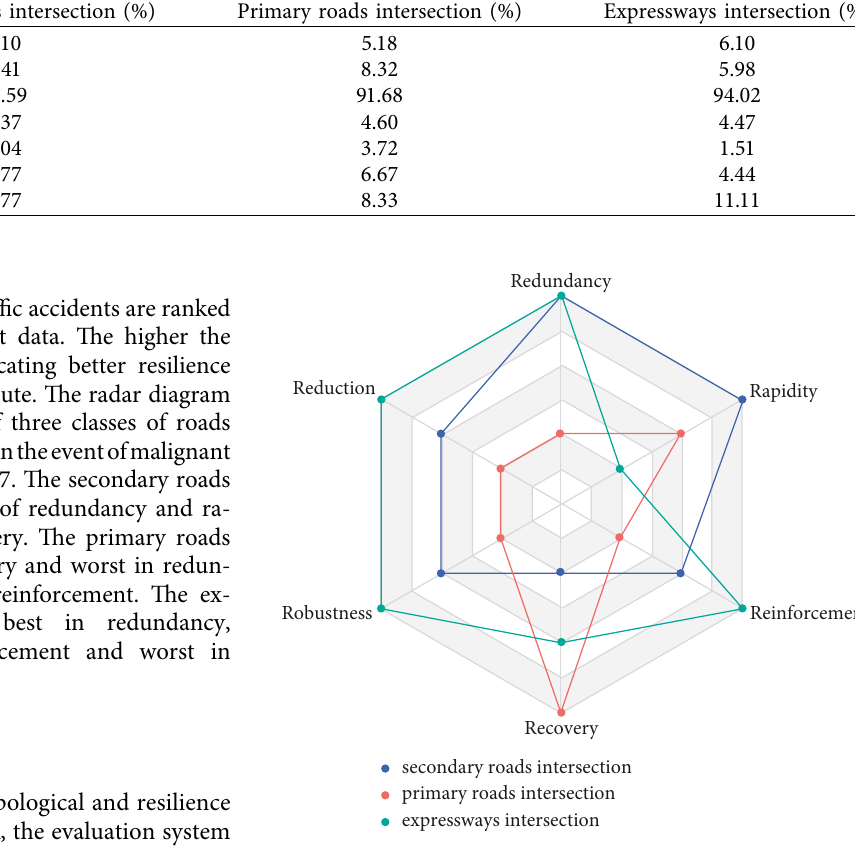
Figure 7: Radar diagram of “6R” resilience performance for three classes of